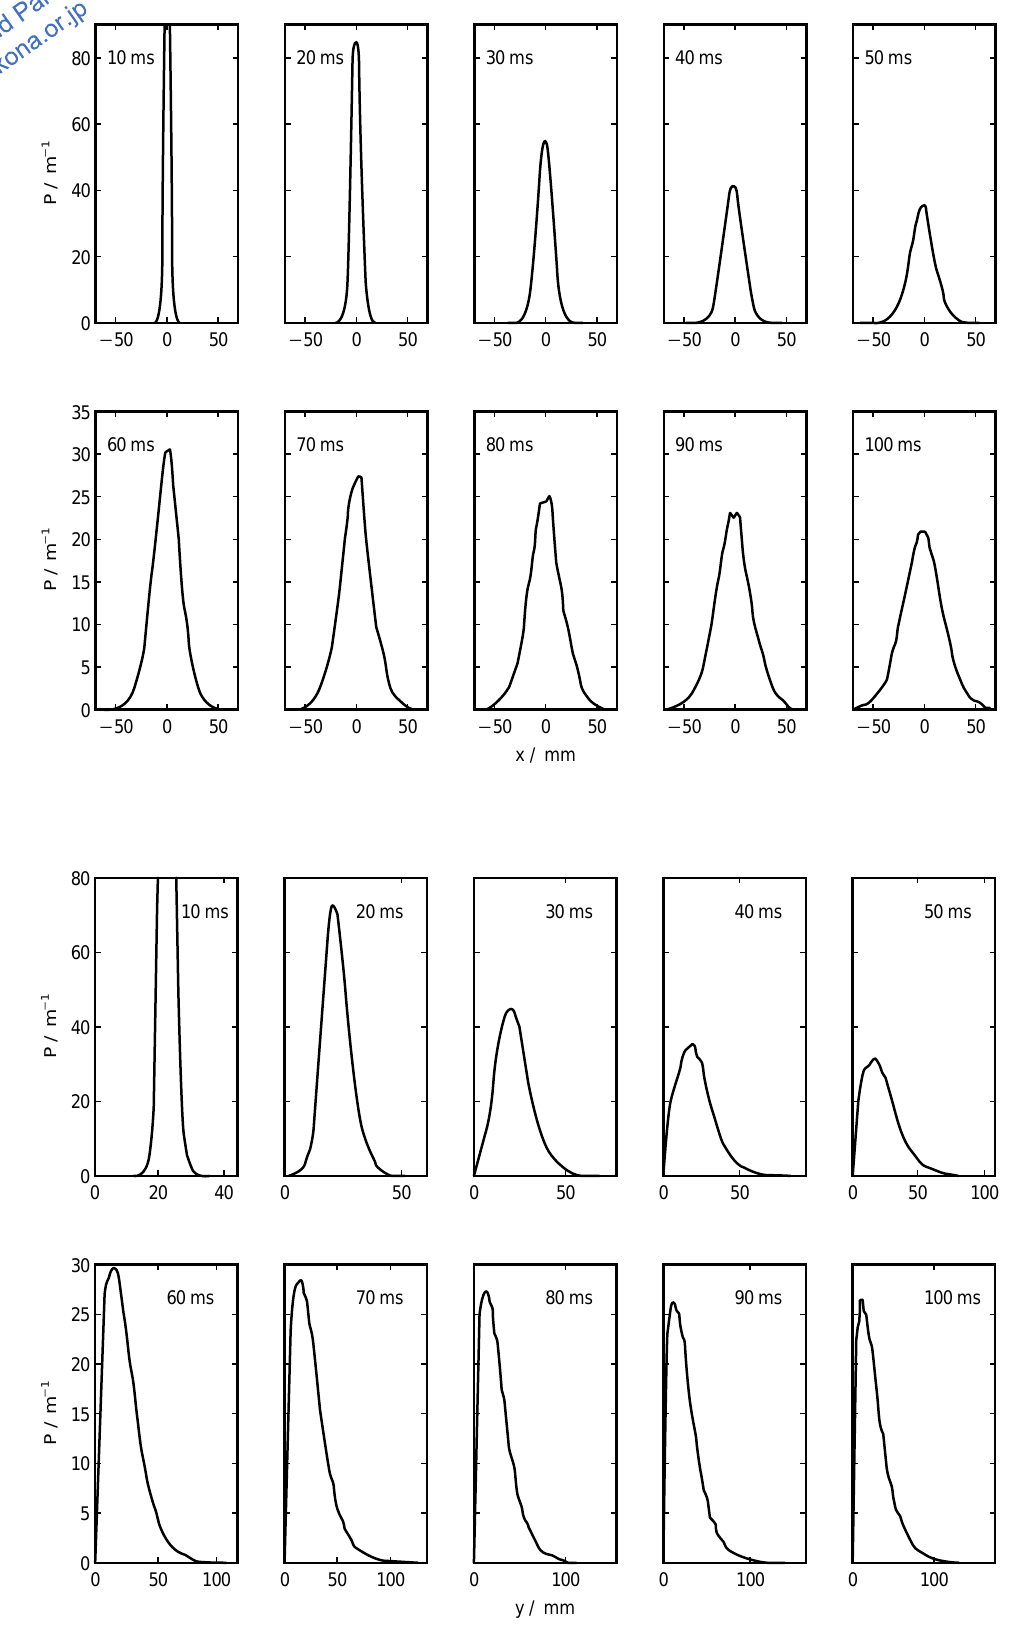
Fig. 2 Evolution of the displacement probability density as a function of time for the mono-disperse case, up to 100 ms, (upper figure) in the x direction and (lower figure) as a function